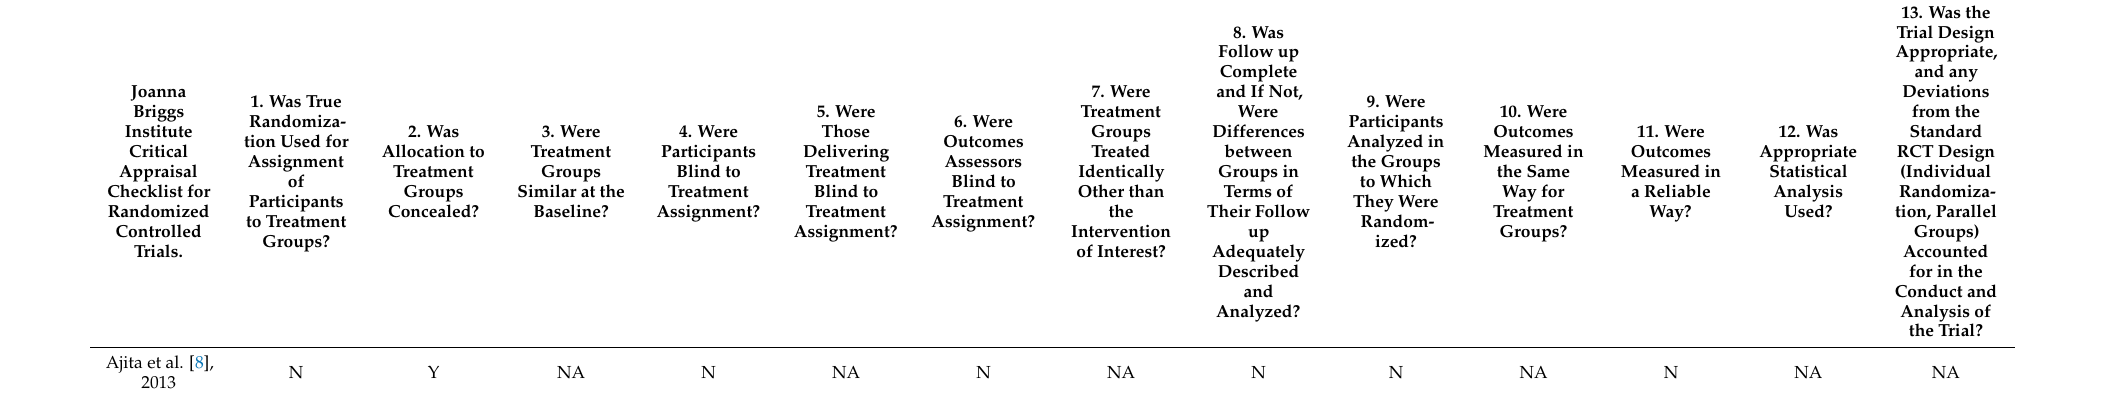
Table 3. Joanna Briggs Institute Critical Appraisal Checklist for Randomized Controlled Trials.